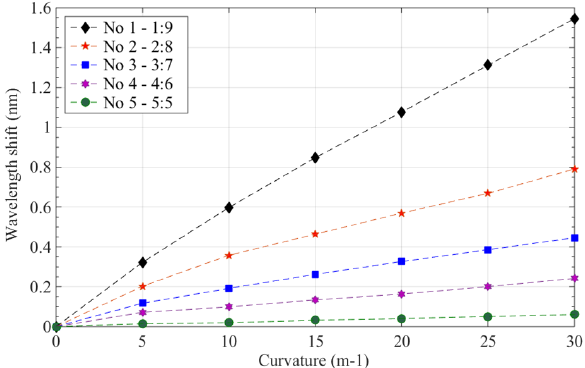
Figure 5. Wavelength shifts of FBG sensors with various curvatures.